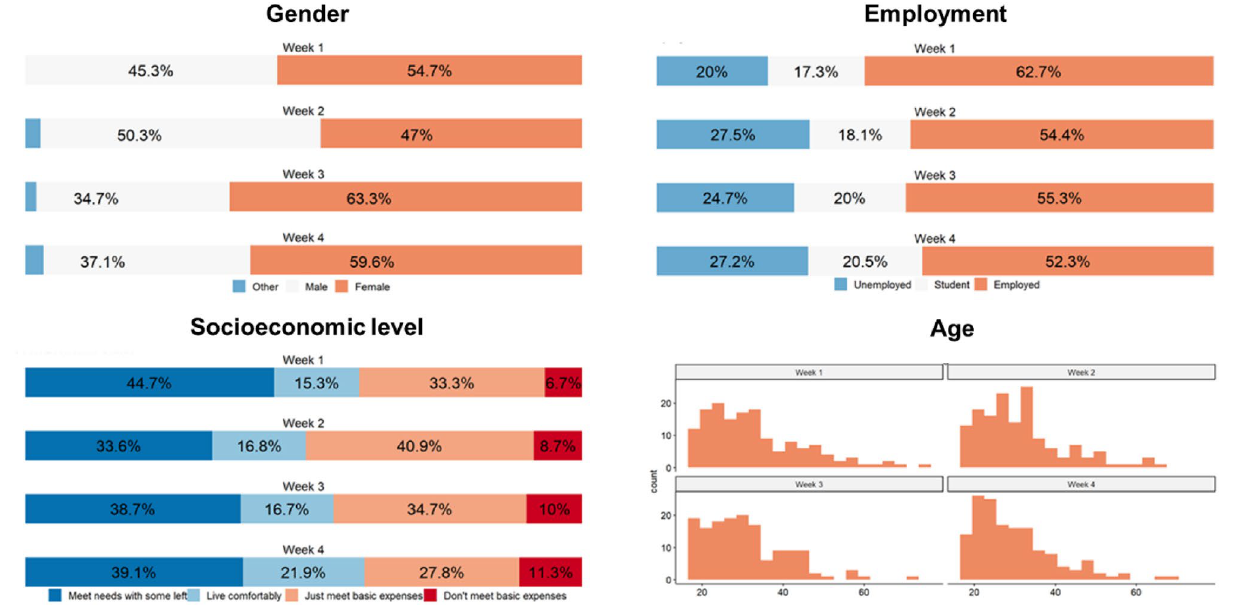
Figure 5. Demographic information for the sample collected in each